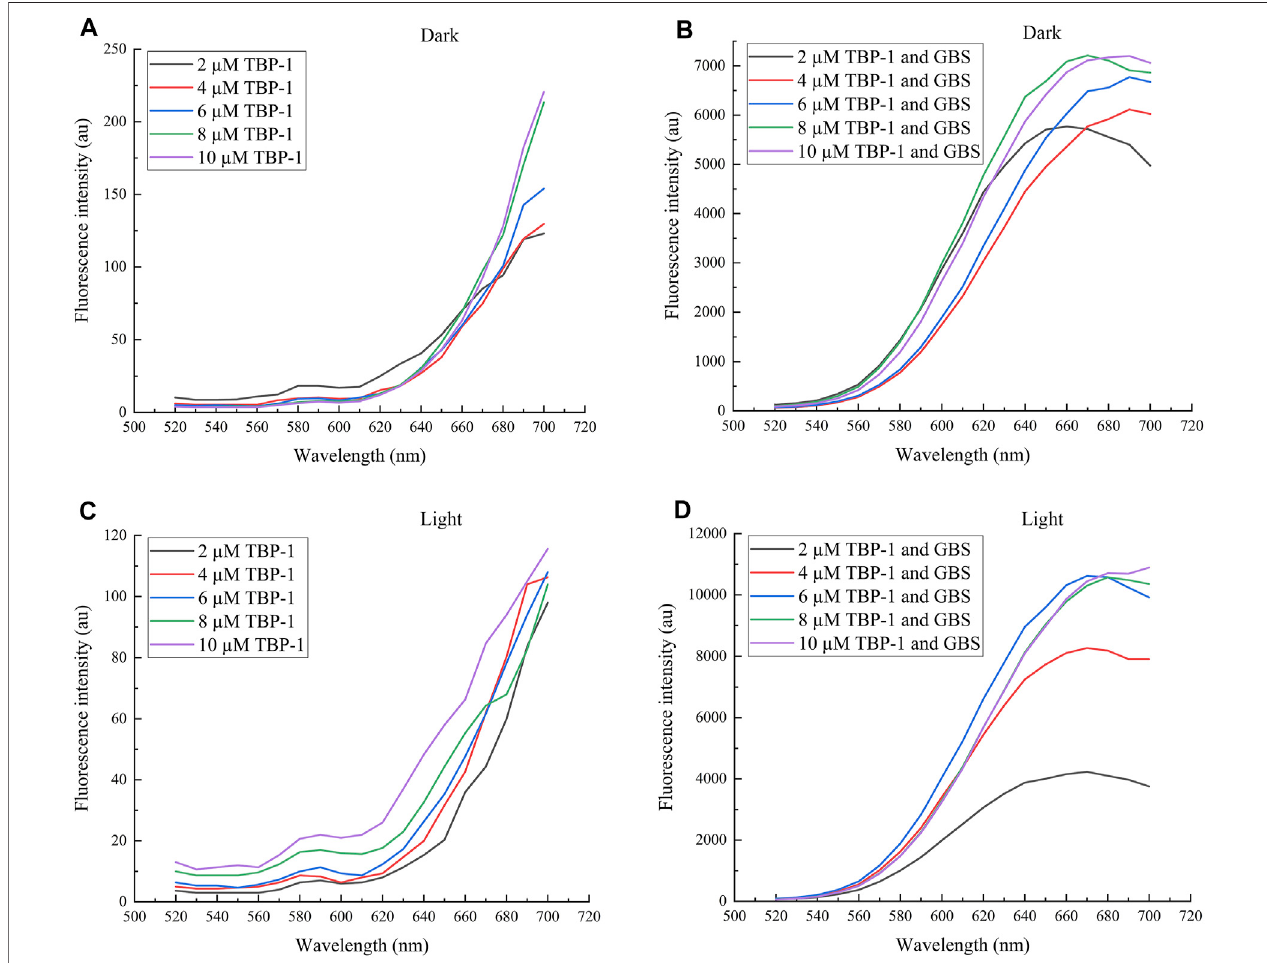
FIGURE 1 | Fluorescence spectra of TBP-1 and GBS incubation with different TBP-1 concentrations in the dark or under white light irradiation for 30 min. (A) Different concentrations of TBP-1 in the dark. (B) GBS incubation with different TBP-1 concentrations in the dark. (C) Different concentrations of TBP-1 with white light irradiation. (D) GBS incubation with different TBP-1 concentrations with light irradiation. λ ex (cid:2) 488 nm.